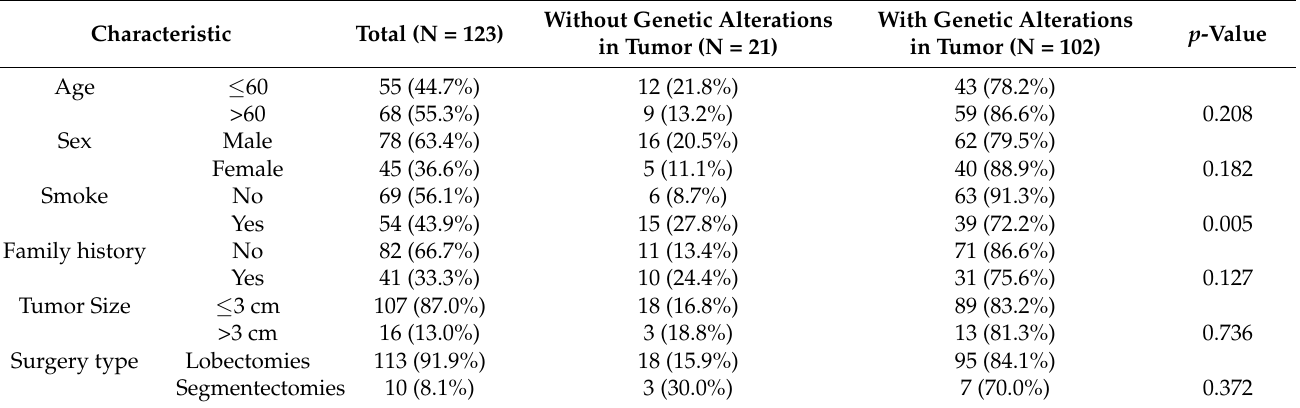
Table 1. Clinical characteristics of 123 stage I LUAD with or without oncogenic alterations.